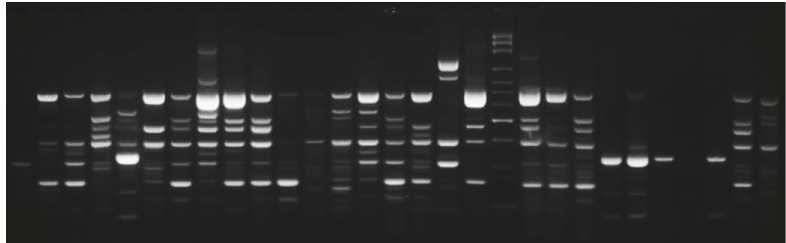
Figure 1: Representative DNA fingerprint pattern of K. pneumoniae clinical isolates genotyped by ERIC-PCR.